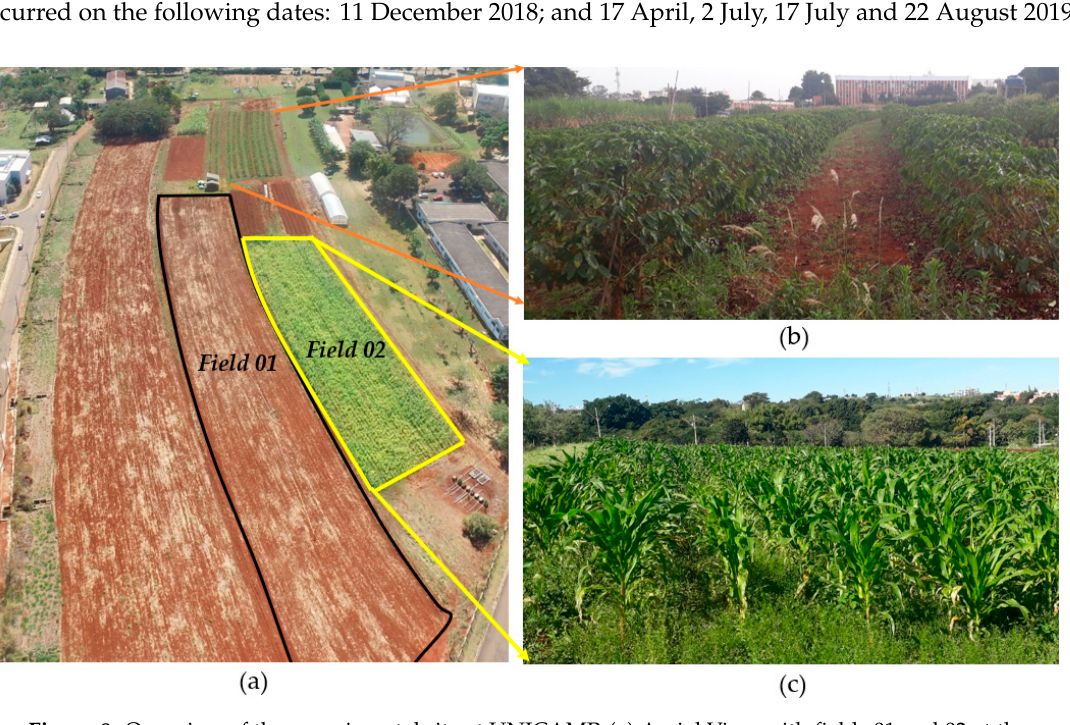
Figure 8. Overview of the experimental site at UNICAMP. ( a ) Aerial View with fields 01 and 02 at the bottom and the coffee crop at the top, on 22 August 2019. Field 01 was bare. ( b ) Ground photo of the coffee crop. ( c ) Ground photo of the corn crop on field 02.